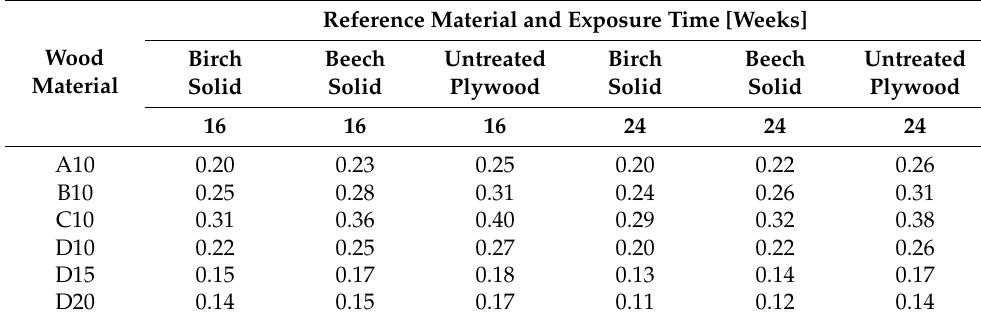
Table 5. x values calculated according to CEN/TS 15083-2 [28] for the developed plywood material against various untreated reference wood materials for 16 and 24 weeks of incubation in unsterile soil.